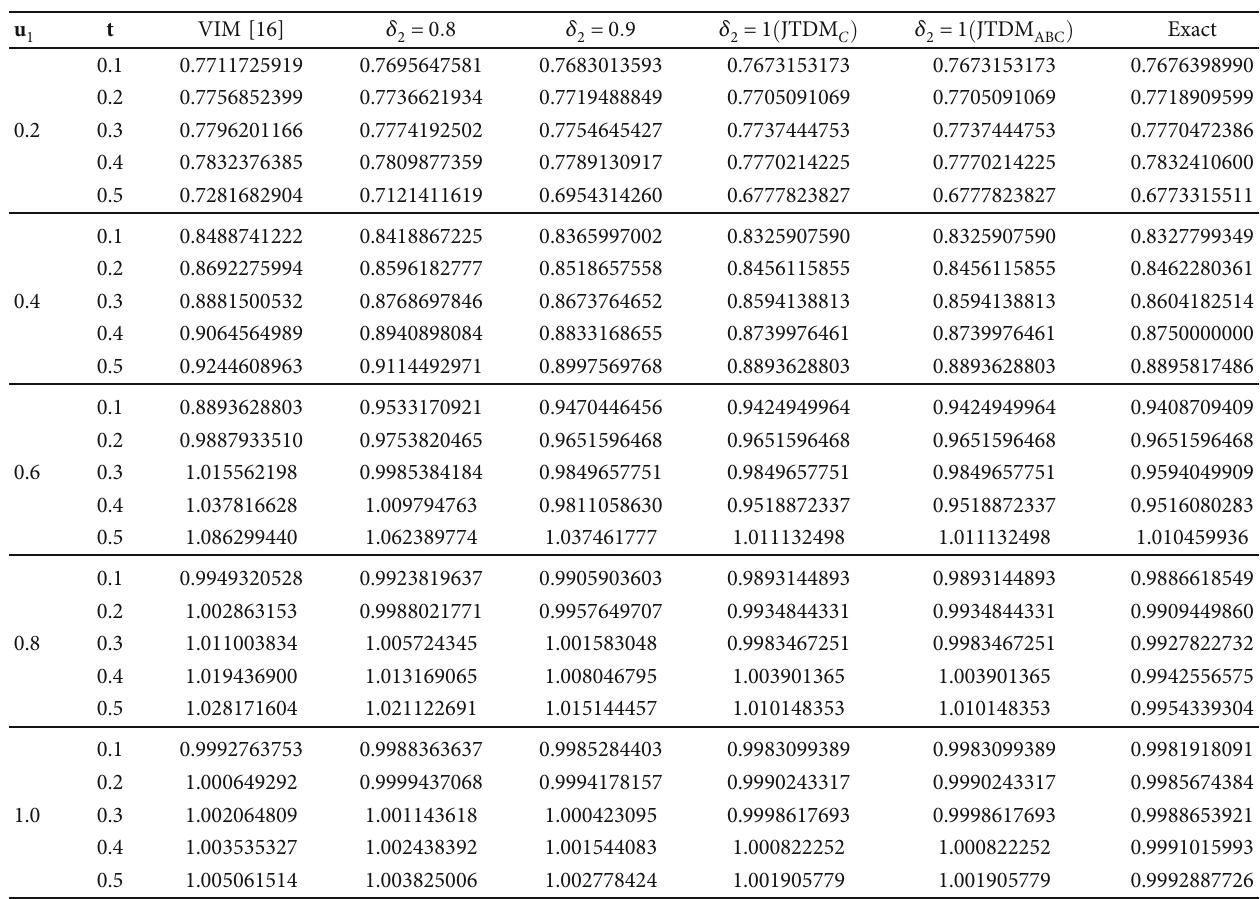
Table 2: The exact JTDM of u 1 and t when u 2 = 0 : 5 and Re = 75